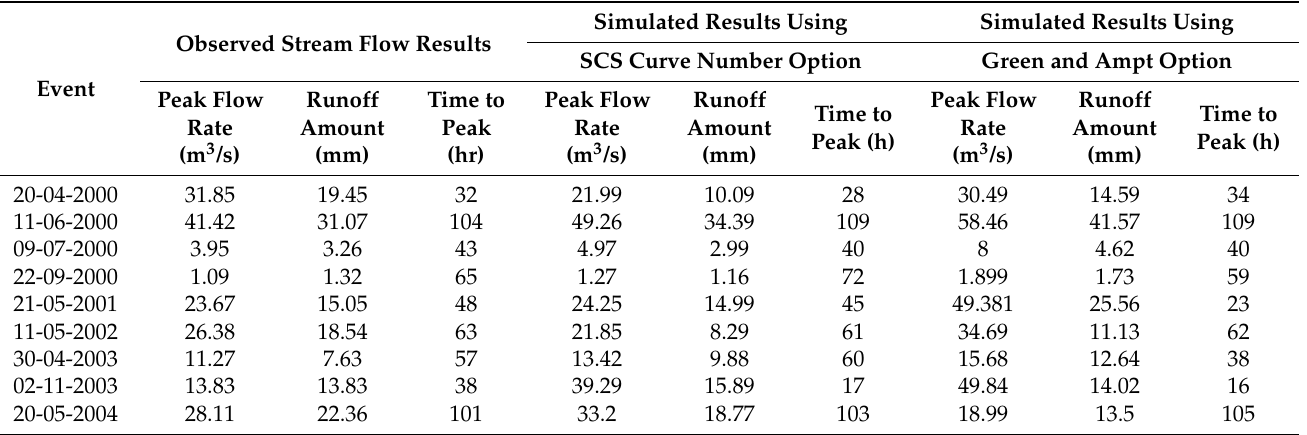
Table 11. Summary of observed and simulated runoff amount, peak flow, and time to peak obtained using calibrated SCS and Green and Ampt Model parameters with MFB-corrected radar rainfall input.